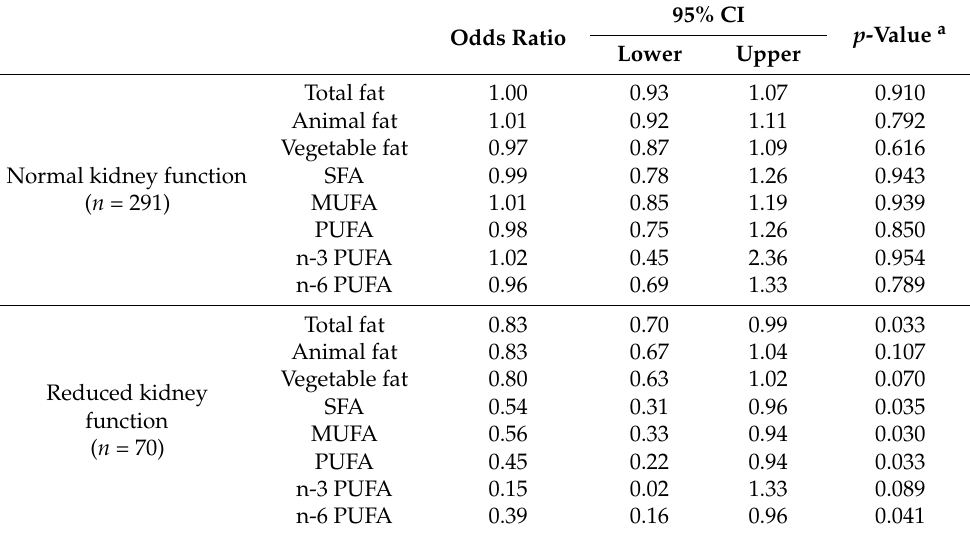
Table 4. Multiple logistic regression analysis of the relationship between fat and fatty acid intake